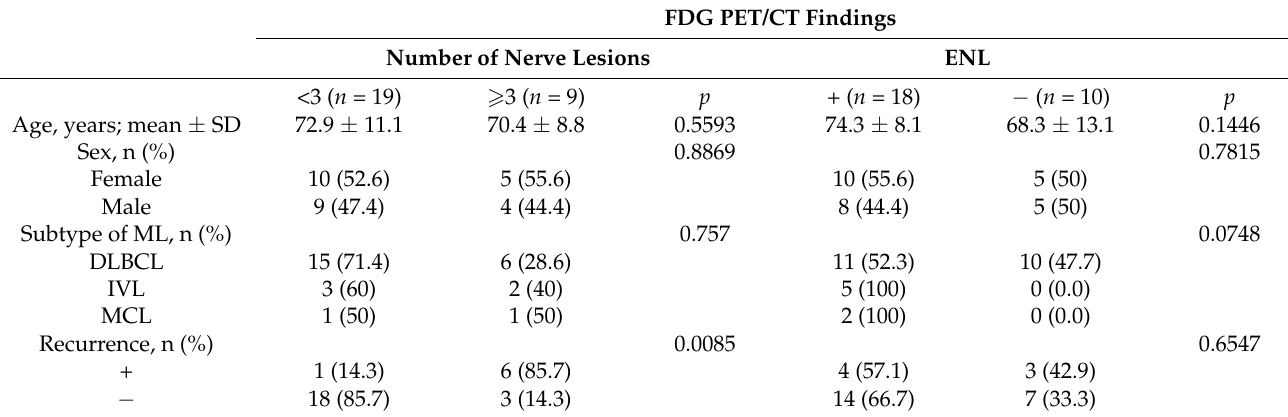
Table 2. Comparison of clinical and FDG PET/CT findings.